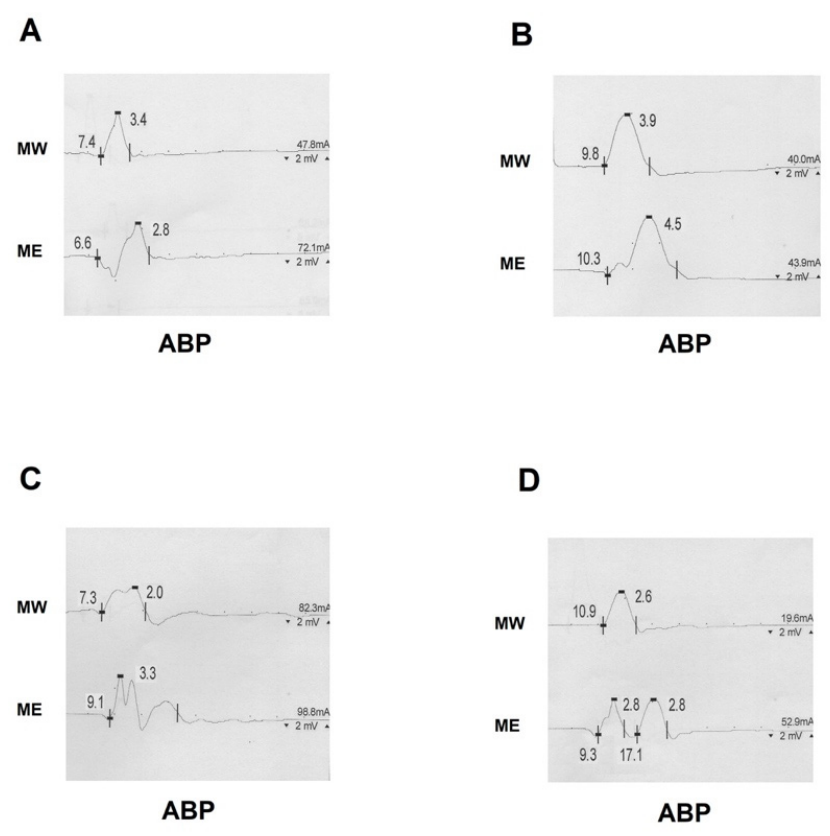
Figure 3. Motor nerve conduction studies from patients with MUC type III and severe CTS. ( A ) A significant positive onset was evident upon ME but not at MW stimulation. ( B – D ) A double component was demonstrated upon ME stimulation. ( B , C ) The more prolonged the DLM was, the more the two components were spaced apart until they were even separated from the baseline ( D ). MUC—median-to-ulnar communicating branch; APB—abductor brevis pollicis muscle; MW—median wrist; ME—median elbow; DML—distal motor latency.